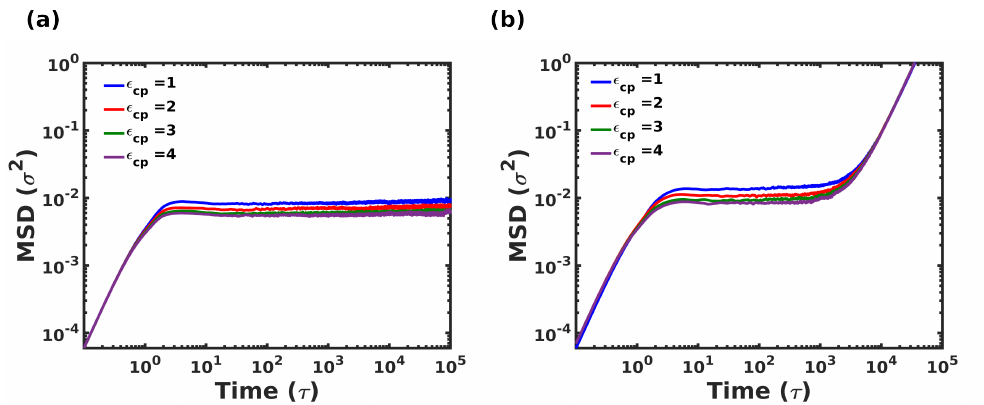
Figure 11. Mean Square Displacement (MSD) as the function of time at equilibrium at T = 0.2 (cid:101) / k B for ( a ) columnar, ( b ) staggered composite systems.